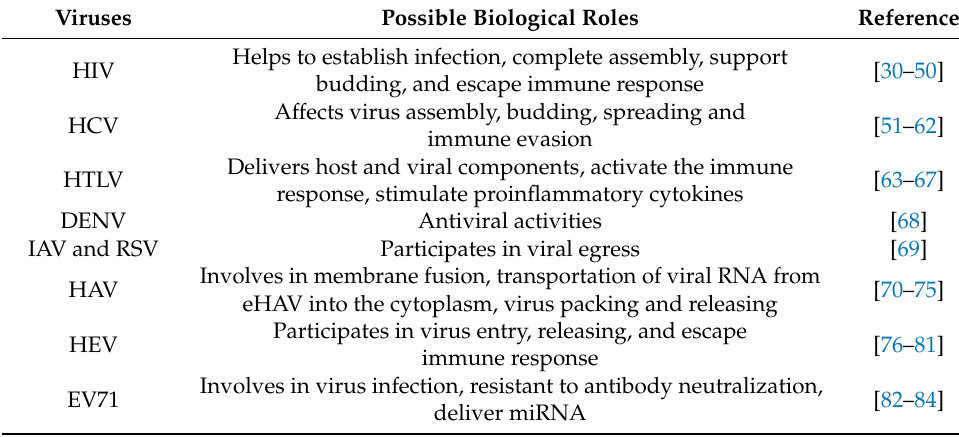
Table 1. The roles of exosomes in RNA virus